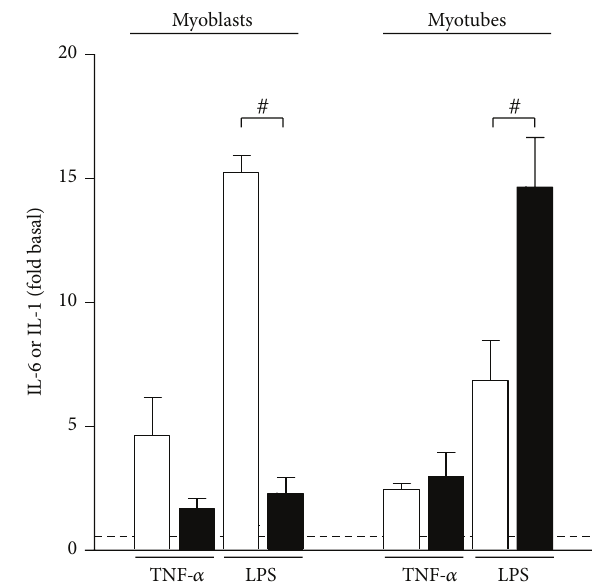
Figure 3: Cultured skeletal muscle cells are characterized by differential responsiveness to pro-inflammatory factors. Human myoblasts and myotubes were exposed to TNF- 𝛼 (100ng/mL) or LPS (100ng/mL) for 24hours. Medium containing TNF- 𝛼 or LPS wasremovedandreplacedwithgrowthmedium.FoldincreaseinIL- 6 (white bars) and IL-1 (black bars) secretion following exposure to TNF- 𝛼 or LPS was calculated to assess responsiveness of myoblasts and myotubes to stimulation with pro-inflammatory factors TNF- 𝛼 or LPS. The dashed line symbolically represents the level of IL-6 or IL-1secretionunderbasalconditions.Dataaremeans ± SEM( n =4– 6). # P < 0.05 versus IL-6 secretion in LPS-treated myoblasts (95% CI of difference: − 18.34 to − 7.53) and myotubes (95% CI of difference: 2.42 to